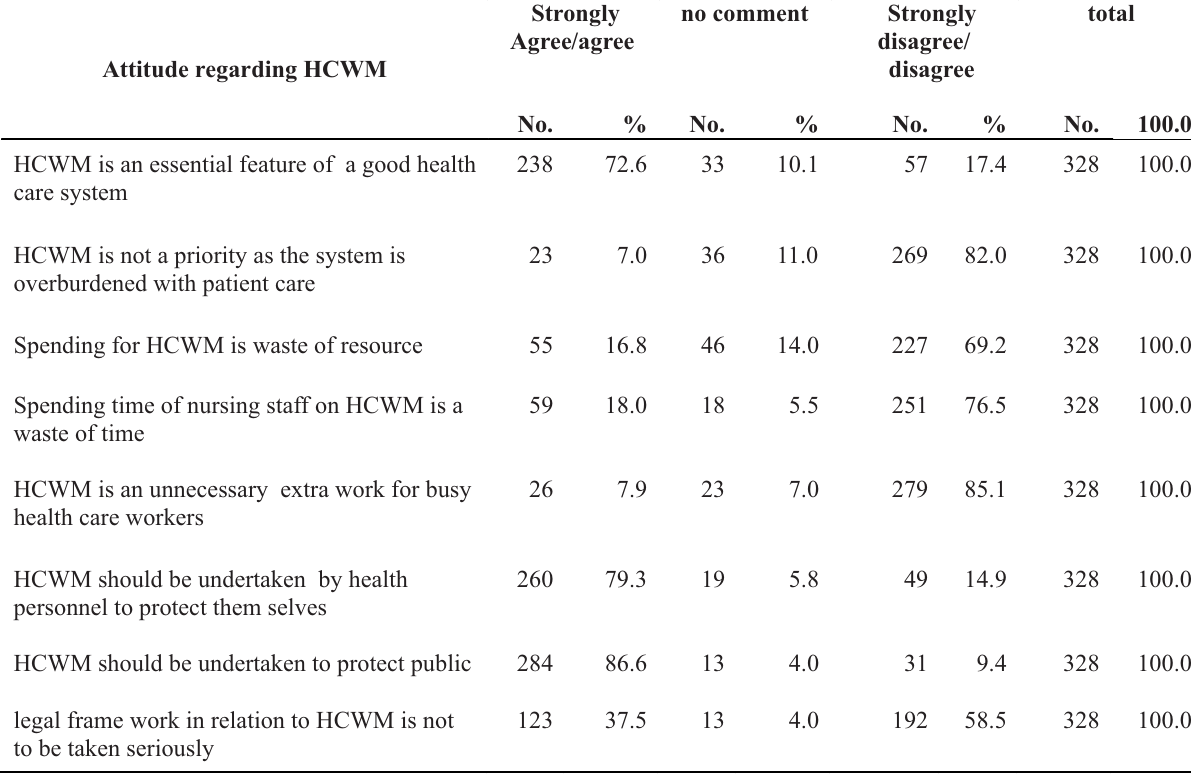
Table 2: Distribution of educational the nursing officers by their attitudes related to HCWM Attitude regarding HCWM